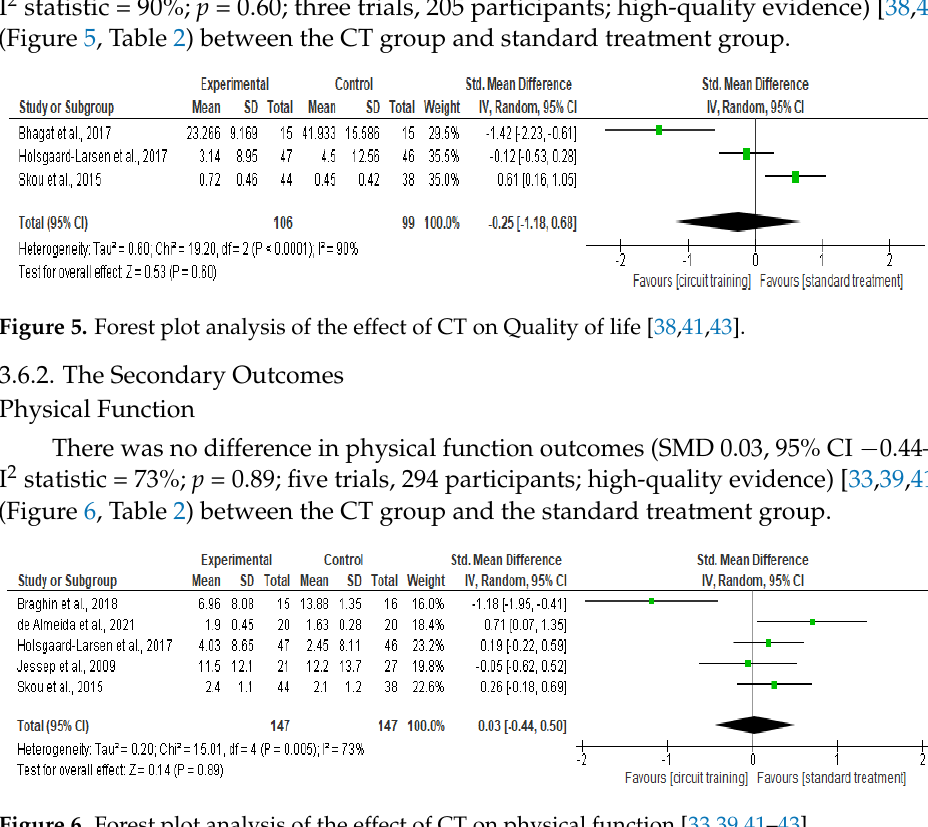
Figure 6. Forest plot analysis of the effect of CT on physical function [33,39,41–43]. Knee Stiffness There was no difference in knee stiffness outcomes (SMD − 0.65, 95% CI − 1.96–0.66; I² statistic = 86%; p = 0.33; two trials, 71 participants; high-quality evidence) [33,39] (Figure 7, Table 2) between the CT group and standard treatment group.